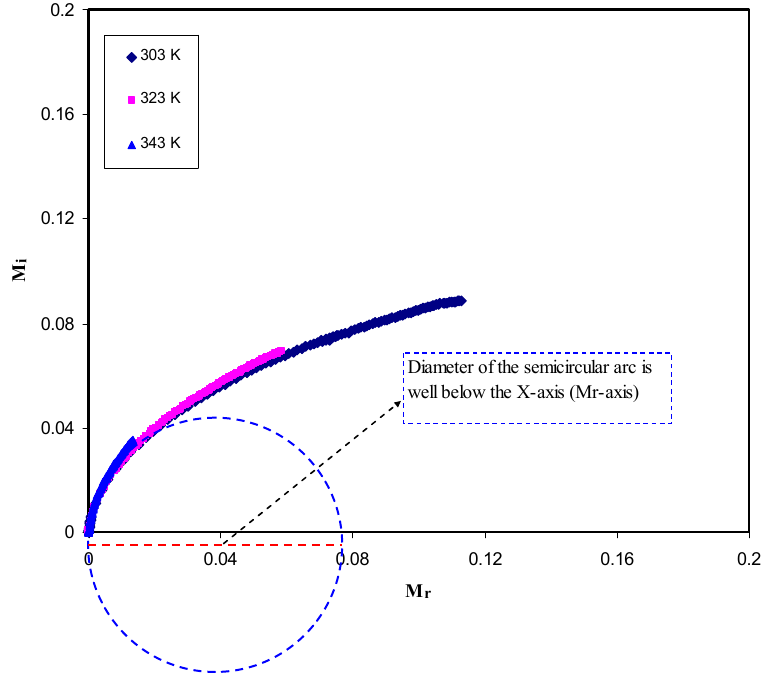
Figure 9. Argand plots for the CS: POZ: MgTf system at different temperatures.